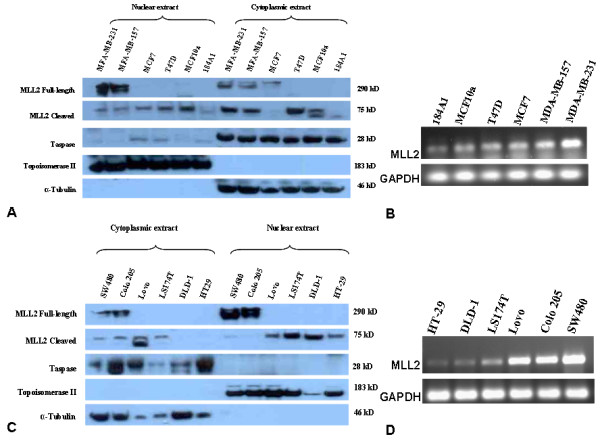
Immunoblot images of nuclear cytoplasmic fractions, and gel images of reverse transcription-PCR (RT-PCR) from human mammary and colonic epithelial cell-lines. (A & C) Cropped immunoblots of nuclear and cytoplasmic extracts from breast (A) and colon (C) cell lines probed for MLL2, taspase 1, topoisomerase IIβ (control nuclear protein) and alpha-tubulin (control cytoplasmic proteins). From top, full-length MLL2 (290 kD), cleaved C-terminus fragment of MLL2 (75 kD), topoisomerase IIβ and alpha-Tubulin are cropped images from the same blot. (B & D) Total RNA was isolated from mammary (B) and colonic (D) epithelial cell lines and subjected to RT-PCR using MLL2 and GAPDH sequence specific primers spanning exon-exon junctions. Cropped images of gels showing amplified products loaded on 2% agarose gels. Top- MLL2, bottom- GAPDH. A. Nuclear and cytoplasmic fractions from mammary epithelial cell lines from a 	single blot. B. MLL2 transcript from mammary epithelial cell lines from a single gel. C. Nuclear and cytoplasmic fractions from colonic epithelial cell lines from a single blot. D. MLL2 transcript from colonic epithelial cell lines from a single gel.